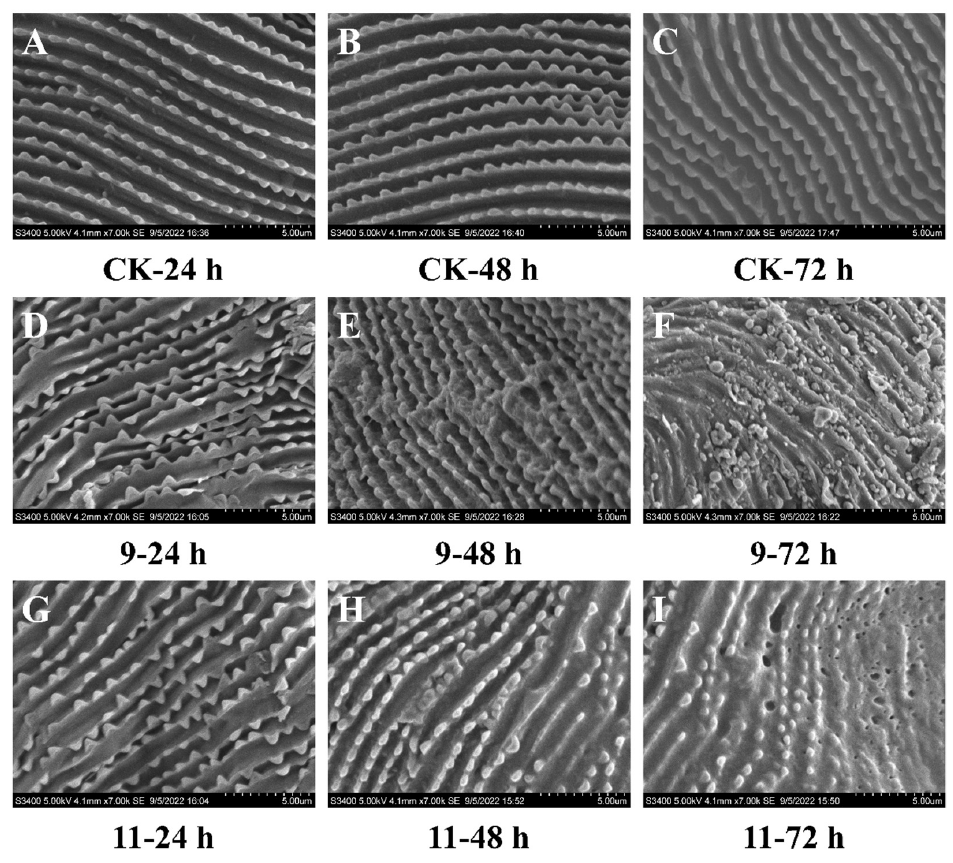
Figure 5. The scanning electron microscope images of T. cinnabarinus treated with compounds 9 ( D – F ), 11 ( G – I ), and aq. Tween-80 (0.1 g/L) ( A – C ) after 24, 48, and 72 h, respectively. Bars ( A – I ): 5.00 µ